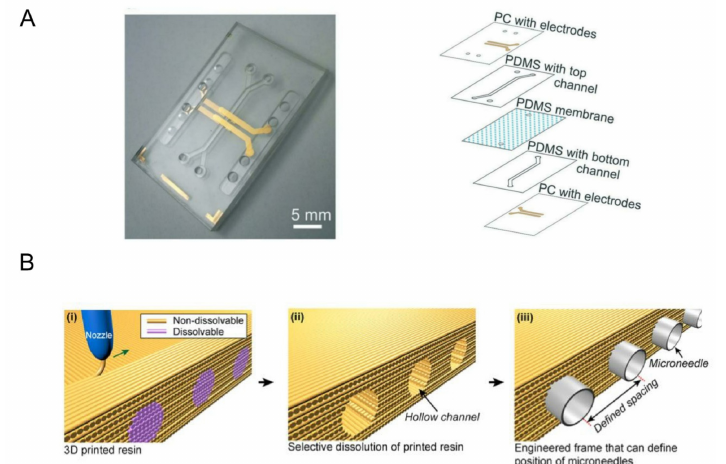
Figure 3. ( A ) Two PC substrates with integrated translucent gold electrodes were added to the upper and lower sides of the gut chip. Reprinted with permission from Ref. [72]. Copyright 2019 Royal Society of Chemistry. ( B ) Schematic illustration for fabrication of 3D printed frame. ( i ) Non- dissolvable and dissolvable resins were co-printed, and ( ii ) the dissolvable resin was selectively removed by submerging in DI water. ( iii ) Hollow channels were used for positioning microneedles. Reprinted with permission from Ref. [75]. Copyright 2015 American Institute of